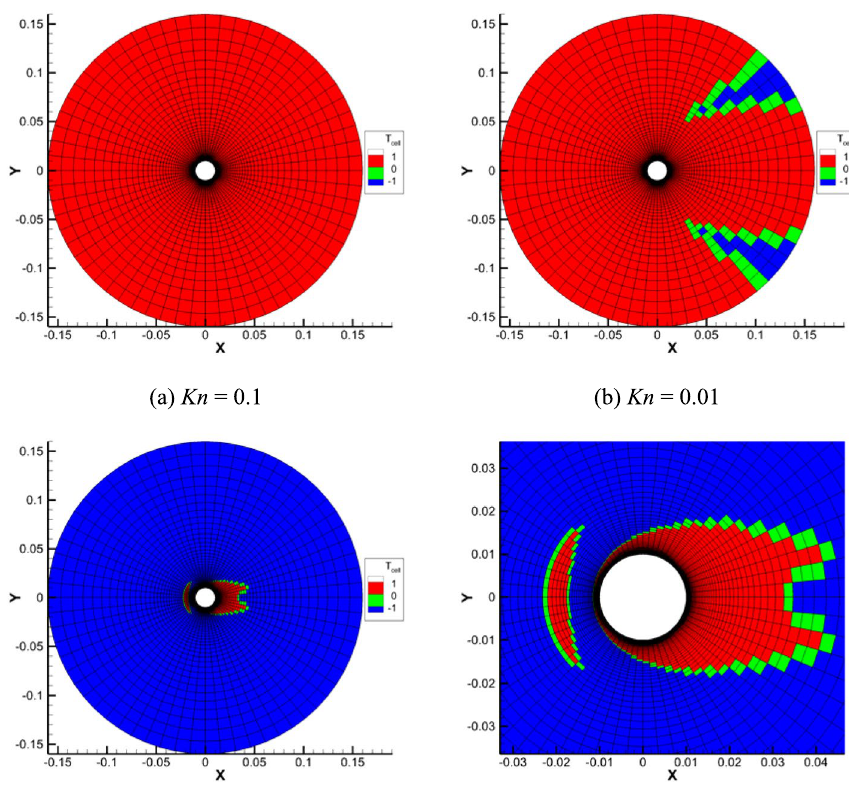
Fig. 19 Distribution of the DUGKS cell and the N-S cell for flow around a circular cylinder with different Knudsen numbers